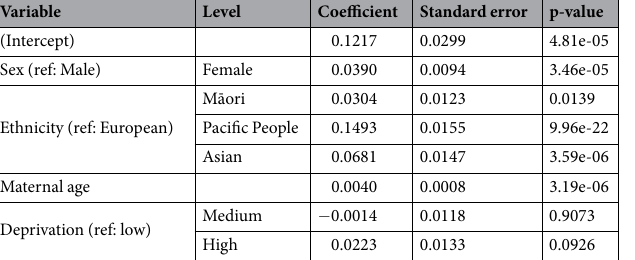
Table 4. Multivariable analysis with the model: log(T/S) ~sex + ethnicity + maternal age + deprivation. The “Other” level in the ethnicity variable was excluded so only the remaining 4 categories of ethnicities (European, Māori Pacific People, Asian) were used in the